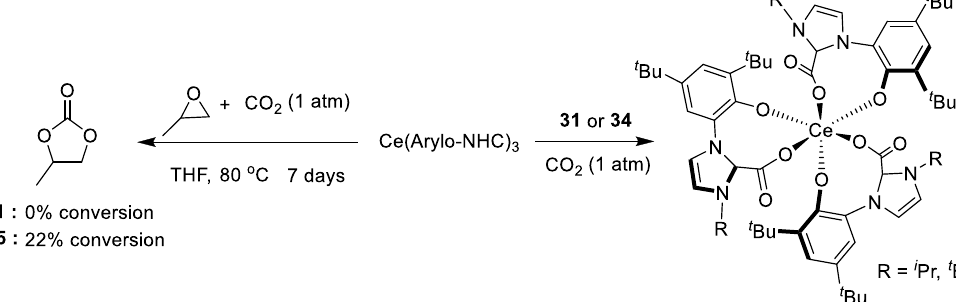
Figure 10. Reactivity of Ce(Arylo-NHC) 3 with CO 2 and their catalytic performance on the formation of propylene carbonate